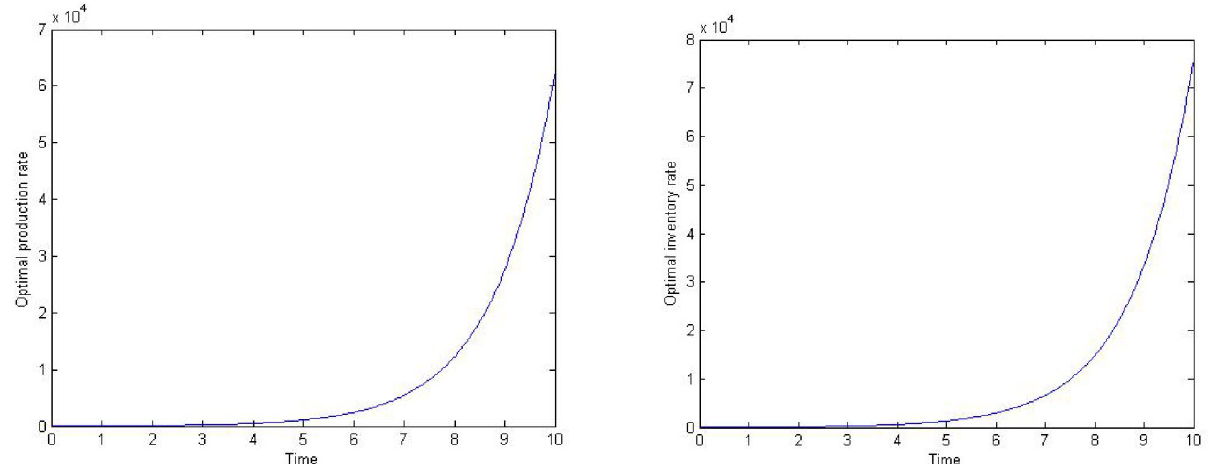
Figure 2. Optimal production rate and optimal inventory rate for